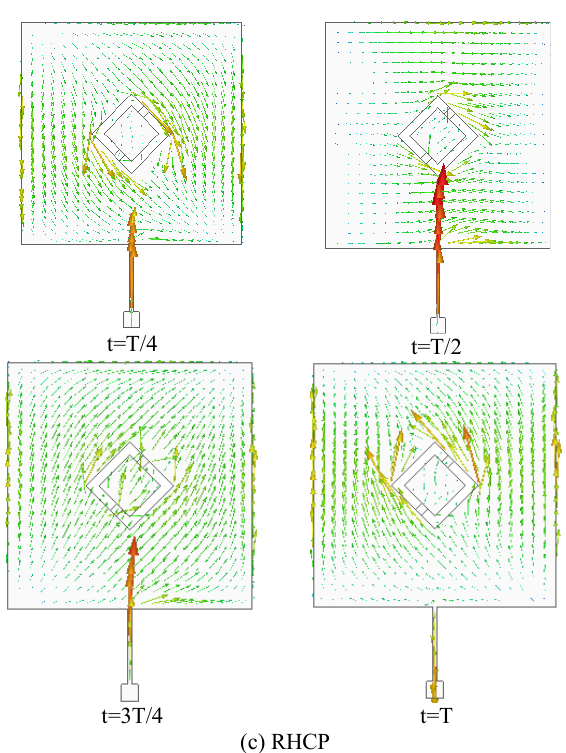
Figure 4: Current distribution on the patch at a different instance of time T